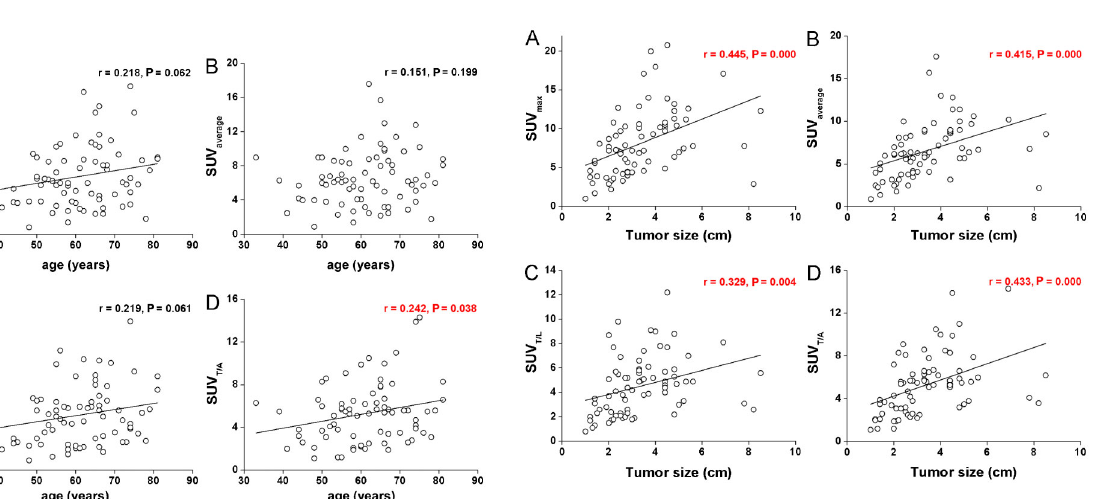
Figure 1. Correlation analyses between age and standardized uptake values (SUVs). SUV max : maximum SUV; SUV avg : average SUV; SUV T/L : ratio of tumor SUV max to liver SUV; SUV T/A : ratio of tumor SUV max to the blood pool SUV of aorta.